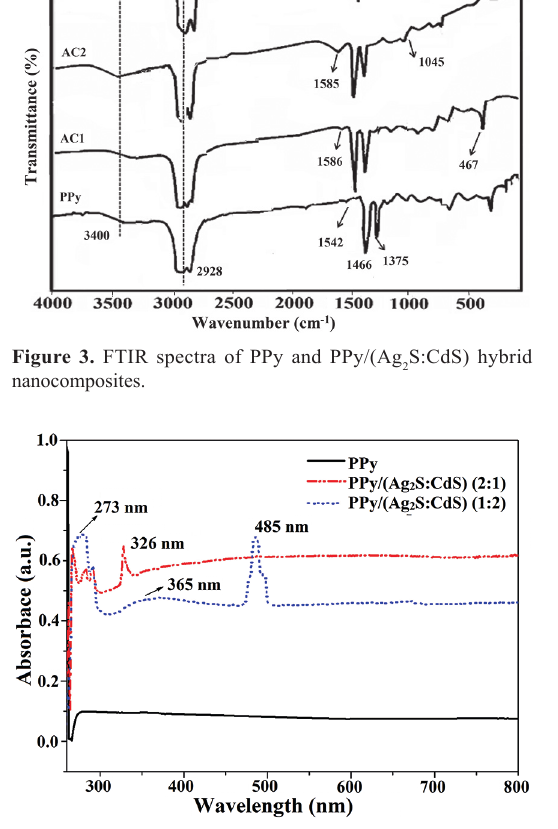
Figure 4. UV-visible spectra of PPy and PPy/(Ag nanocomposites. observed at ~ 273-275 nm in AC1 and AC3